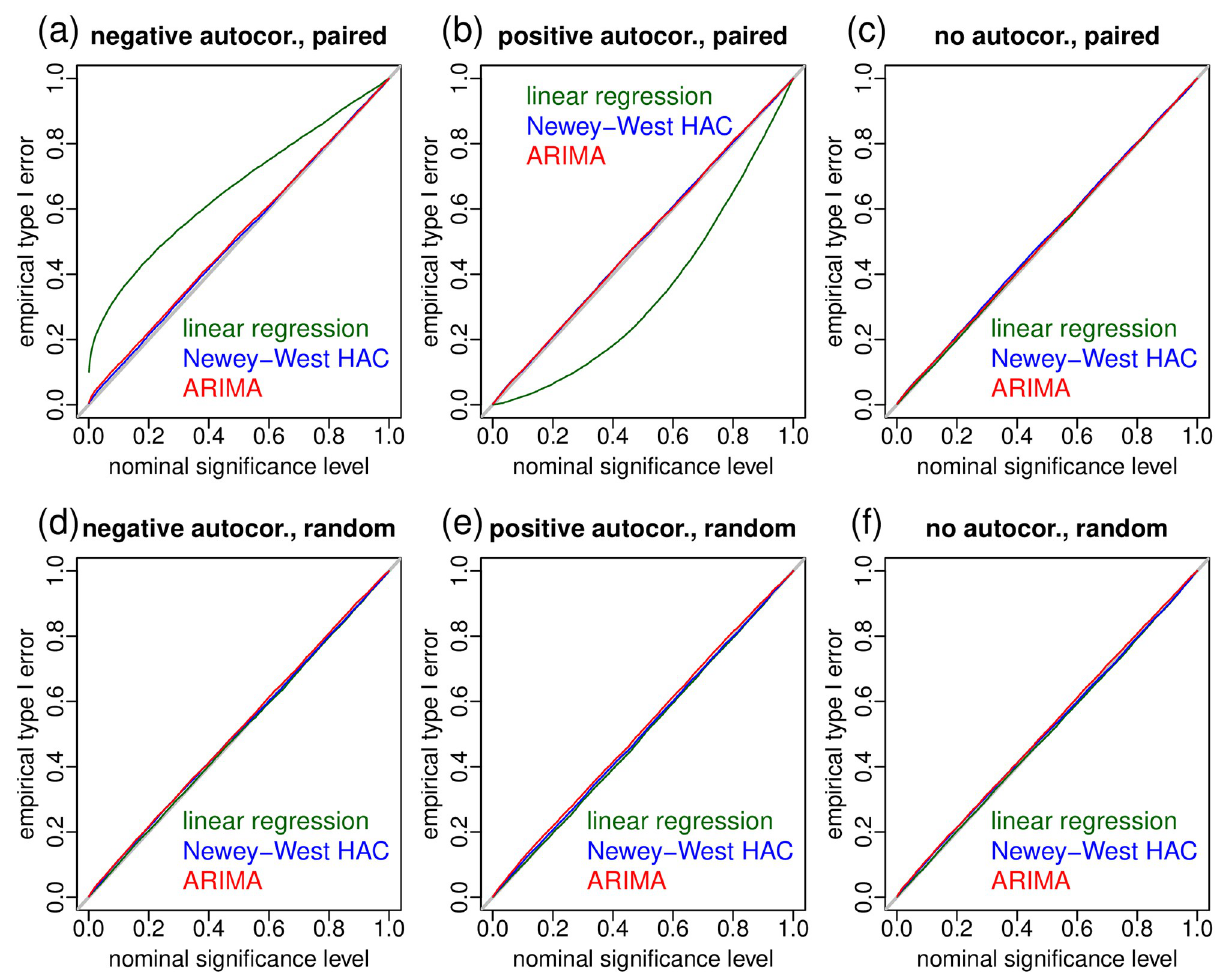
Fig 6. Assessing empirical type I error rates for the linear regression, Newey-West HAC, and ARIMA errors approaches. We run 3 separate simulation experiments for the negative (panels a and d), positive (panels b and e) and no autocorrelation (panels c and f) cases. Each experiment was based on 10,000 simulated data-sets generated according to the simulation parameters presented in Table 2. All panels report the nominal significance level ( α ) in the x-axis, and the respective empirical type I error rate in the y-axis (computed as the proportion of p-values smaller than the nominal significance